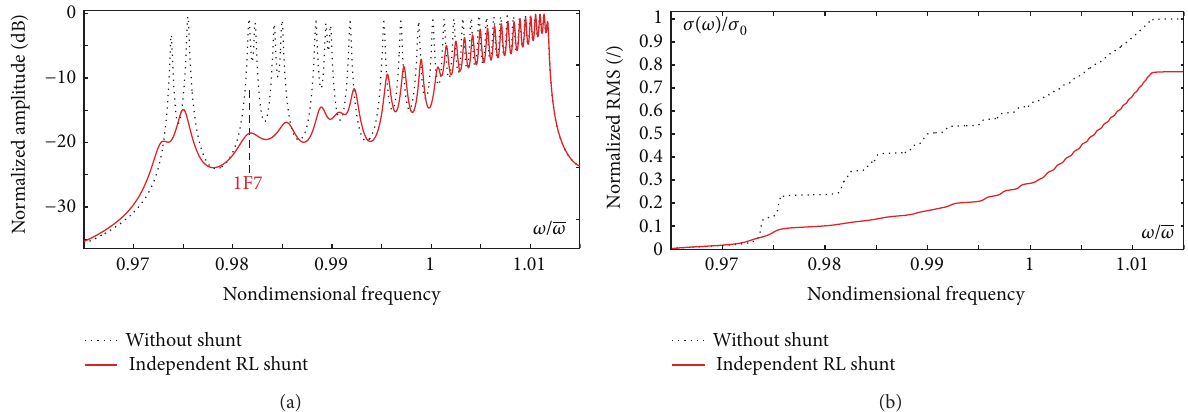
Figure 9: Simulation response of one blade with independent RL loops. (a) Normalized FRF 𝑇(𝜔) = | ̇𝑥/𝜂| between the forcing function and the velocity measured at the blade tip, (b) cumulative RMS of 𝜎(𝜔) .